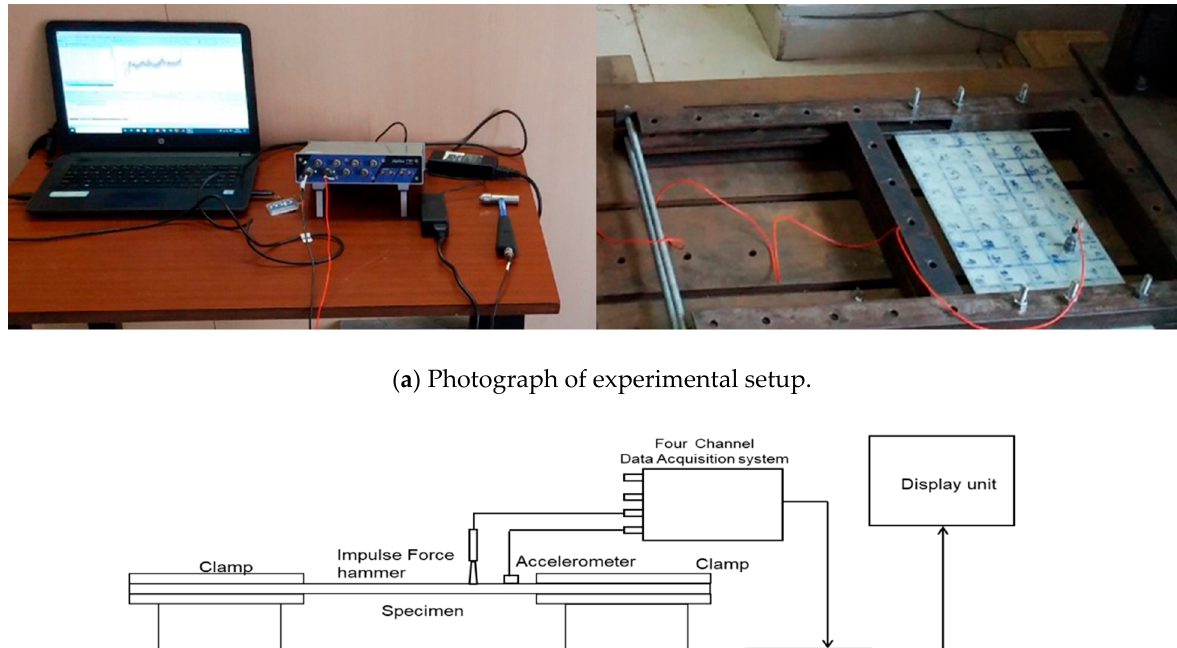
Table 2. Comparison of the natural frequencies of a tapered composite plate derived by utilizing the present FEM with those presented in [38].